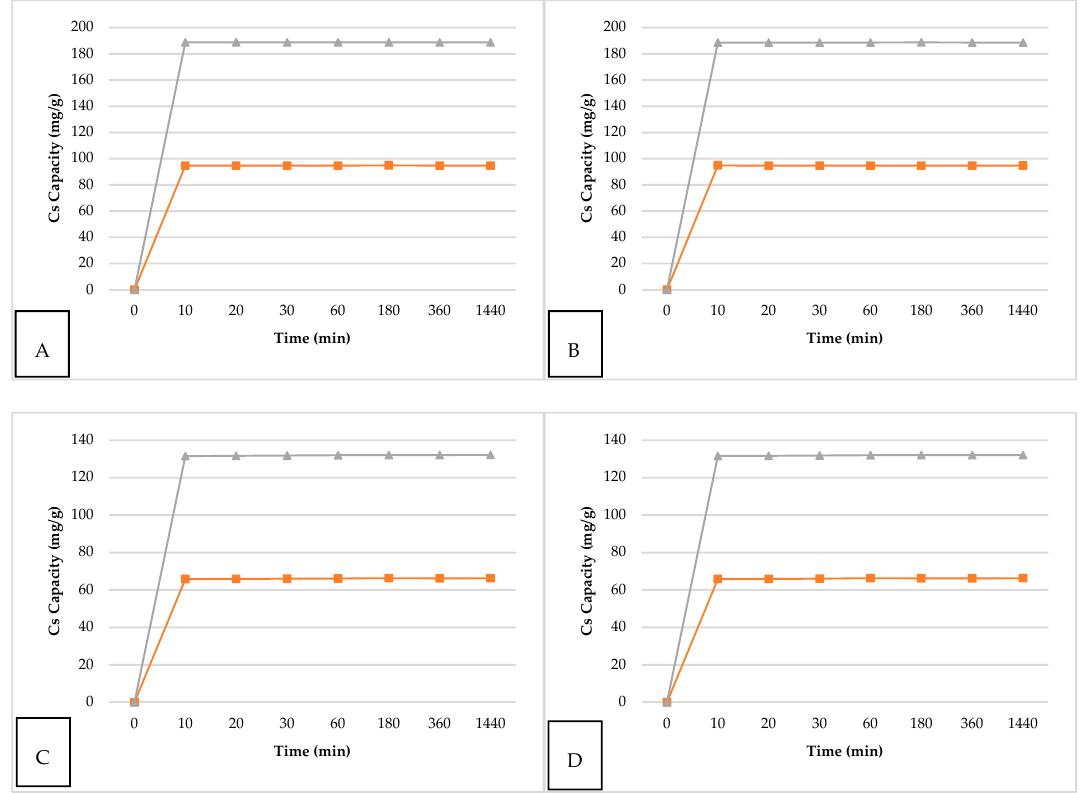
Figure 3. Measured Cs + capacities (mg/g) over time (min) for 5.0 mM (orange squares) and 10.0 mM Cs + in virgin AMP (top left, A ), irradiated AMP (top right, B ), virgin AMP-PAN (bottom left, C ), and irradiated AMP-PAN (bottom right, D ) from 3 M HNO 3 solution.